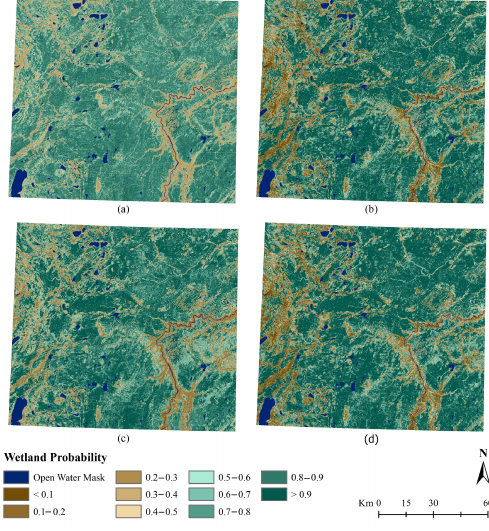
Figure 2. Probability surfaces produced by each of the four final boosted regression tree (BRT)